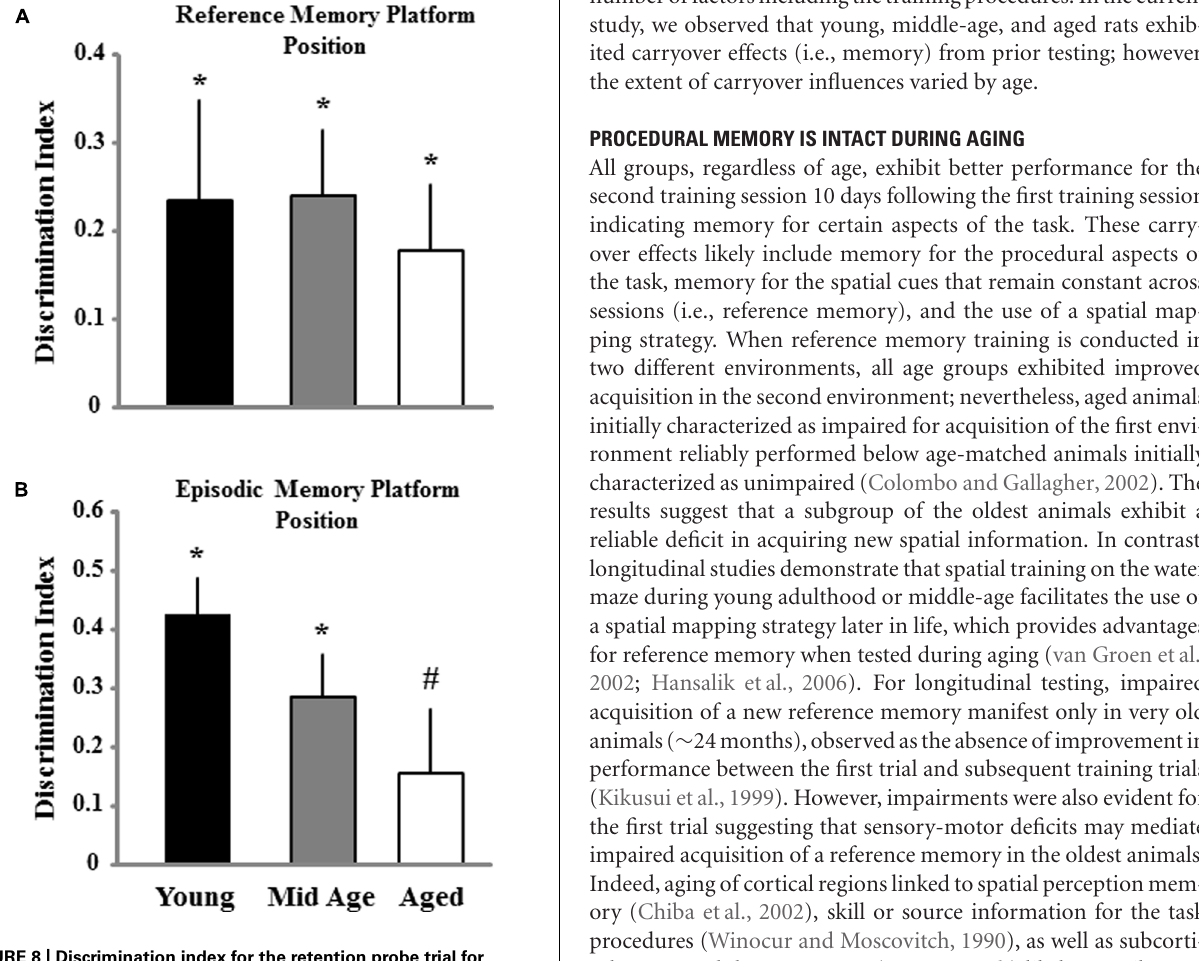
FIGURE 8 | Discrimination index for the retention probe trial for animals trained to either the reference (A) or episodic platform position (B) during the second session of spatial training. The retention probe trial was instituted 24 h after the final block of training in order to assess spatial memory abilities for young, middle-age (Mid Age), and aged animals. Asterisk and pound sign signifies a significant difference from chance performance and young animals, respectively ( p <